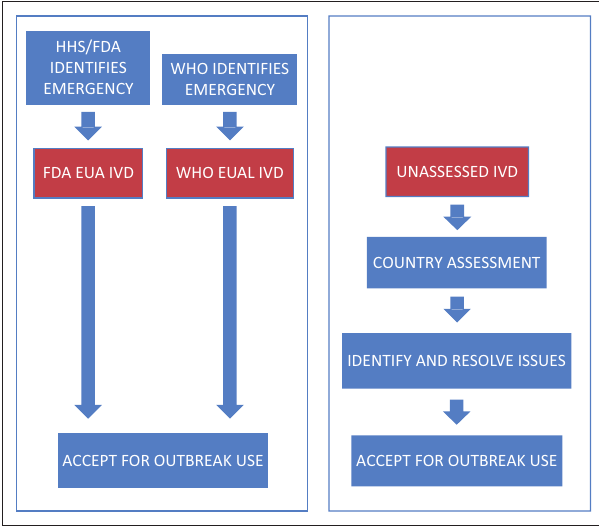
FIGURE 2: Assessment scheme for adoption of outbreak-use in vitro